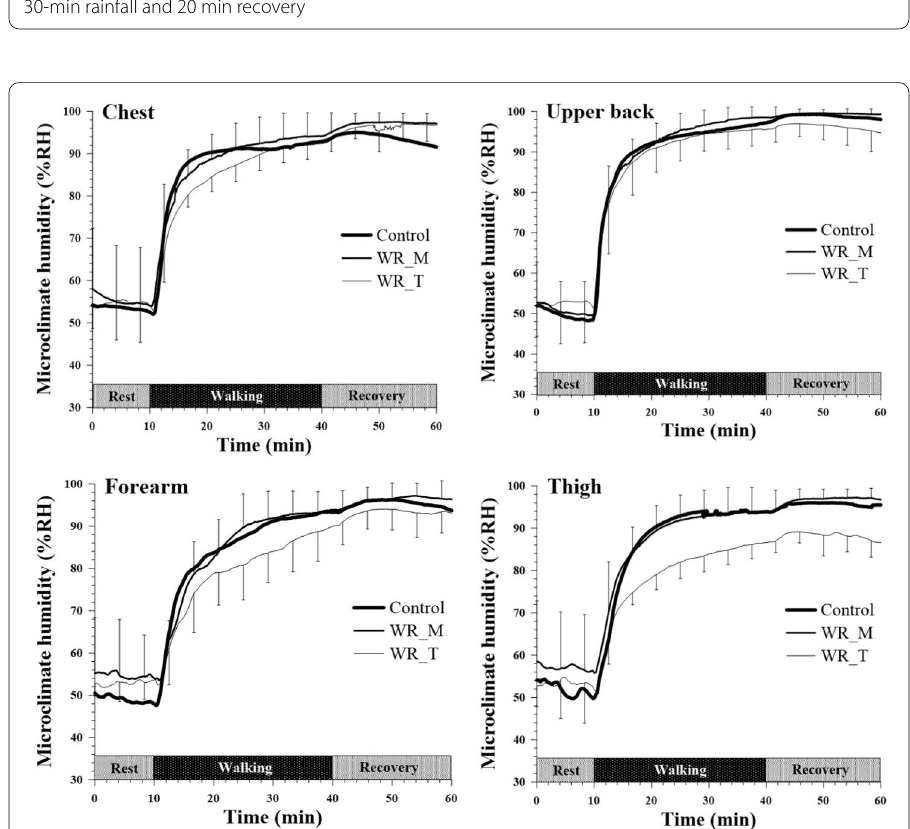
Fig. 6 Time courses of clothing microclimate humidity on the four body regions during rest, walking under 150 mm rainfall and